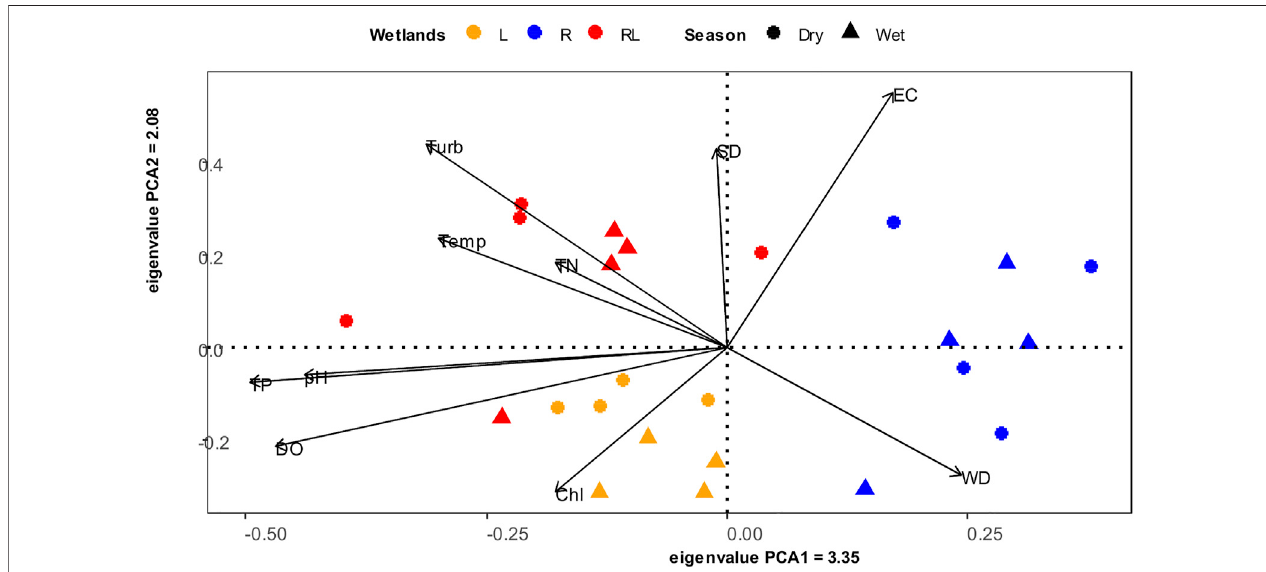
FIGURE3 | Biplots ofPrincipal Component Analysis(PCA) ofenvironmental variables in relation todifferentwetland types during the dry and the wet seasons. pH, SD sediment depth , WD water depth , Chl chlorophyll-a, EC speci fi c conductance , Turb turbidity , DO dissolve oxygen concentration , and Temp temperature.